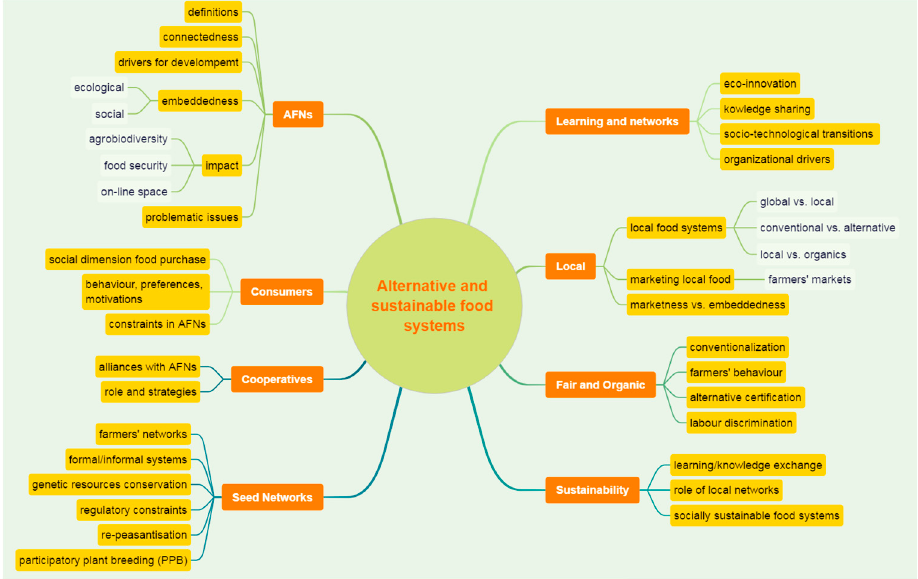
Figure 4. Concept map of topics and sub-topics identified with the content analysis.